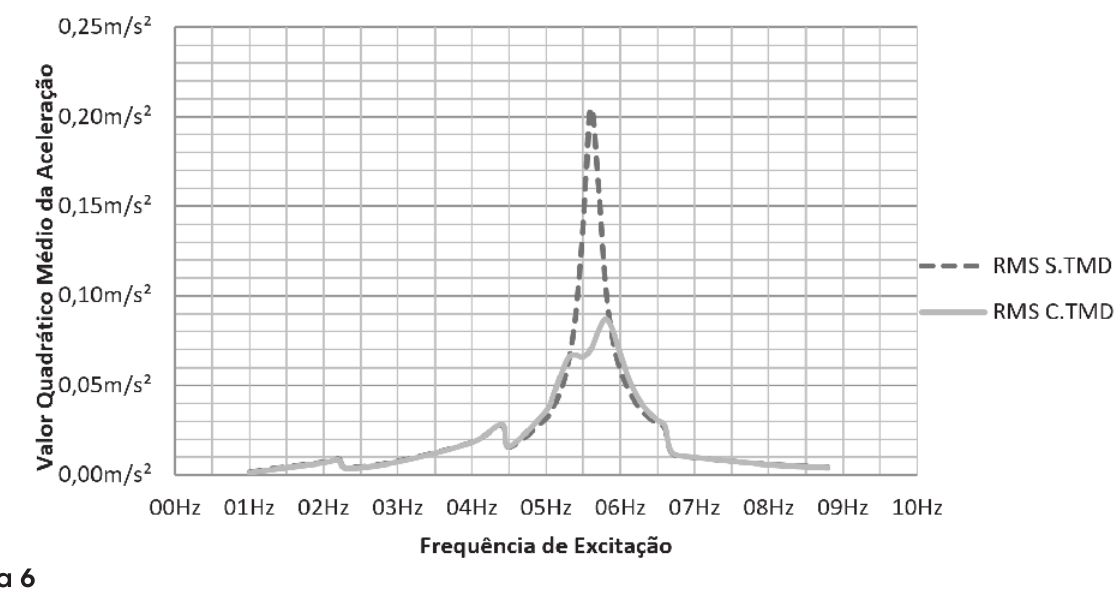
Figura 5 Deslocamento quadrático médio x frequência